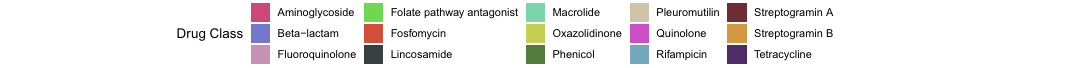
geopolitical issues. b Stacked bar chart of relative abundances per drug class per country. Each panel represent countries in a World Bank region and is ordered by the Shannon diversity of class-level